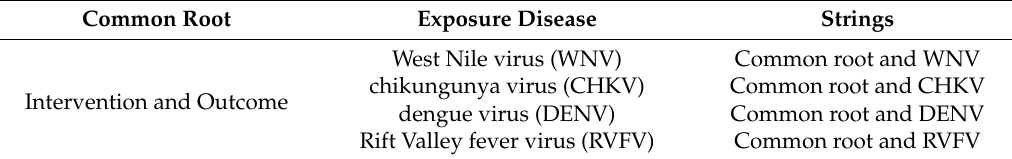
Table 3. Review search